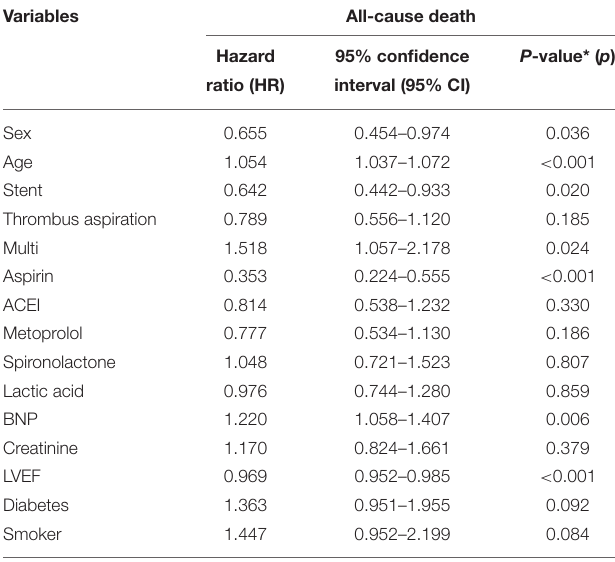
TABLE 4 | Multivariate Cox regression analyses of all enrolled patients.